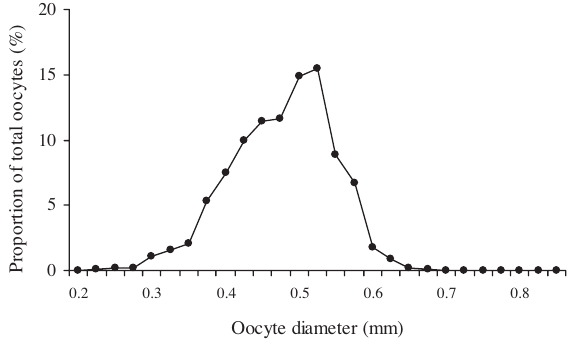
F IG . 7. – Size distribution of oocytes in the ovary of round sardinel- la just prior to spawning (early June 2001), Aegean Sea. A total of 105 females were used, the total length of which ranged between 156 and 228